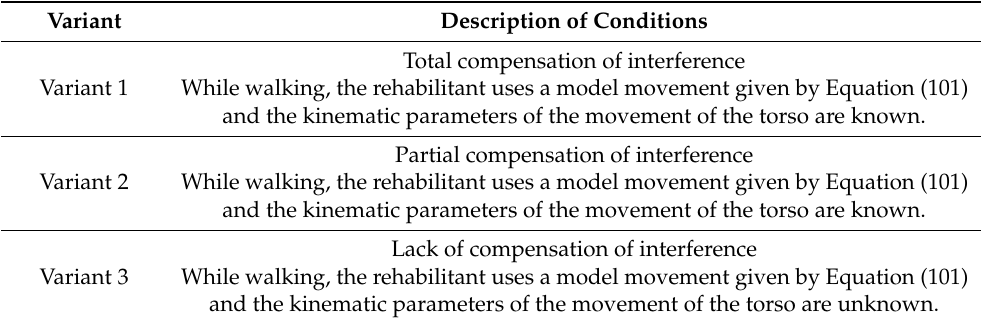
Table 2. Variants of the simulated operating conditions of the rehabilitation device.